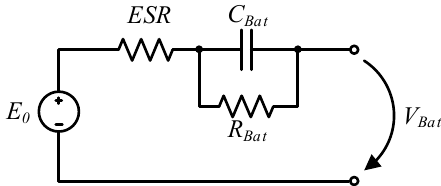
Figure 8. Equivalent Thevenin electrical model for the battery energy storage system (BESS).